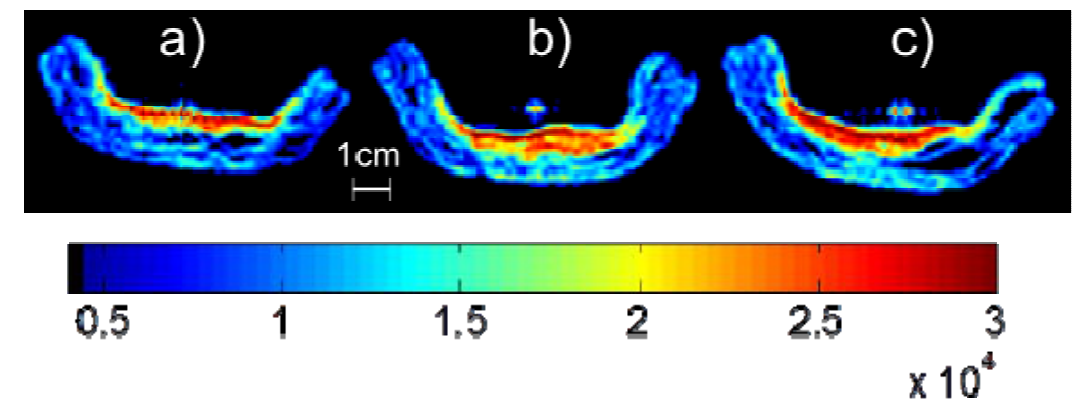
Figure 5. Single Point Images of pastry and jelly samples, where the jelly has a concentration time of 90 min. The temperatures of the jellies at the time of introducing to the crusts were ( a ) 30 °C, ( b ) 50 °C, and ( c ) 70 °C. The color scale represents the MR signal intensity with blue representing low signal intensity (e.g., pastry without jelly due to low moisture content) through green to red which represents high signal intensity (e.g., jelly due to high moisture content).